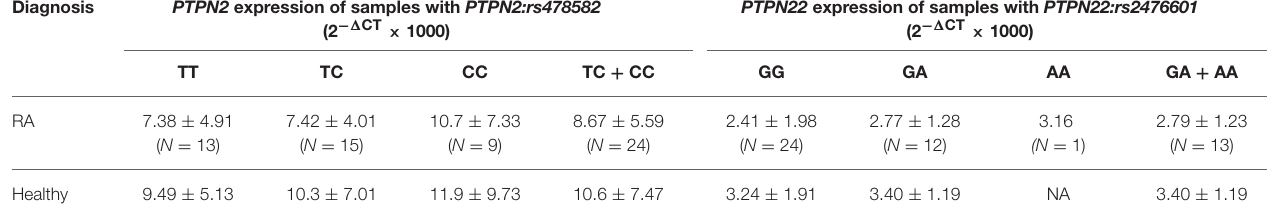
TABLE 3 | Effect of PTPN2:rs478582 and PTPN22:rs2476601 on PTPN2/22 expression. Diagnosis